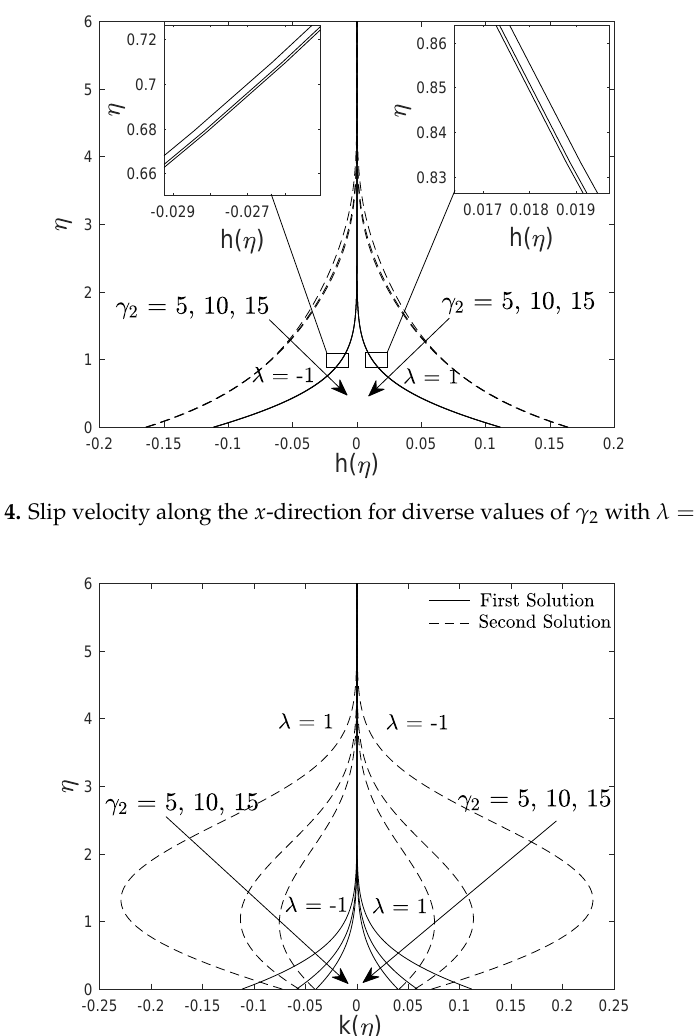
Figure 5. Slip velocity along the y -direction for diverse values of γ 2 with λ = −